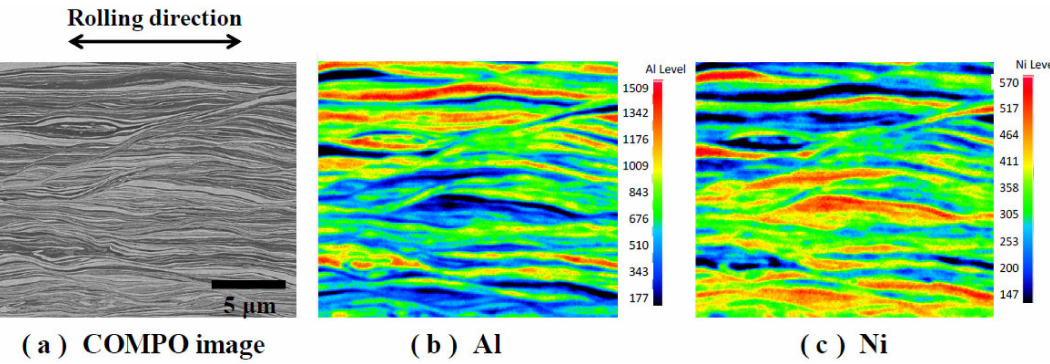
Figure 3. Cross-section observation of the structure of the Al / Ni multilayer sheet after 40 passes by the FE-EPMA. ( a ) photo of backscattered electron compositional image, ( b ) Al concentration, and ( c ) Ni concentration distributions analyzed by the wavelength dispersion type